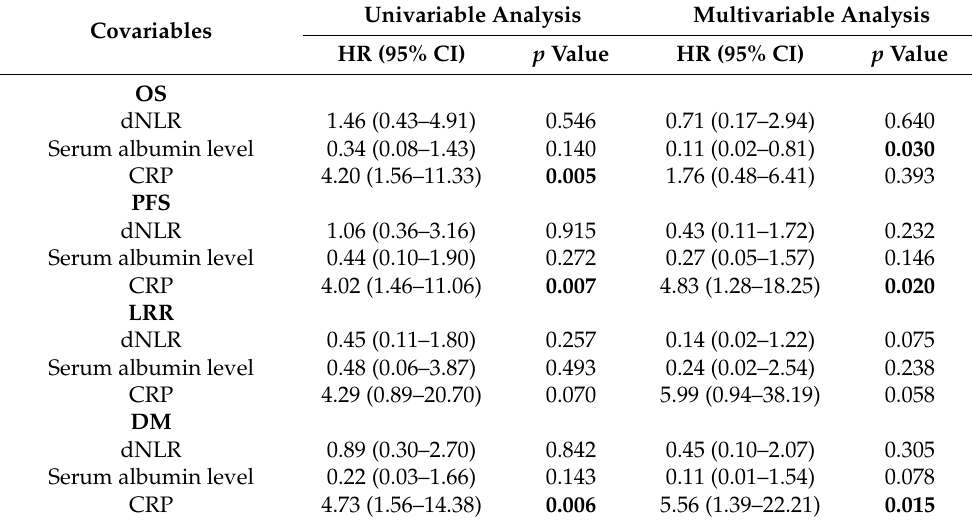
Table 3. Post-treatment peripheral blood biomarkers and Survival and Disease Control. Univariable Covariables